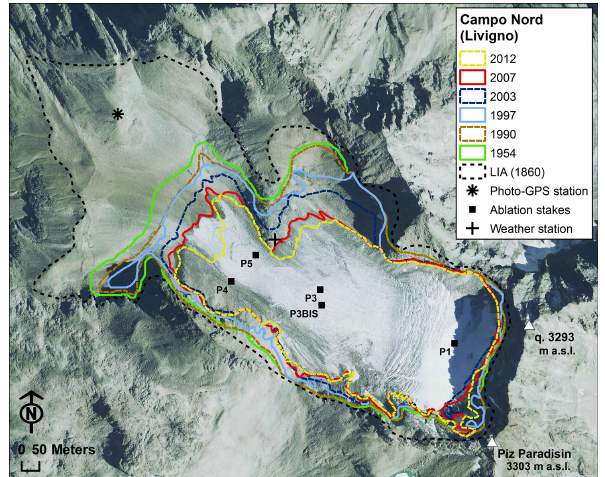
Figure 3. Example of multitemporal glacier delineation, i.e., Campo Nord glacier (Livigno sub-region), with the 2007 or- thophoto in the background. The slightly larger extension of the glacier top area in 2012 compared to 2003 and 2007 is due to the presence of a snow field developed after the 2007 season that was characterized by very limited snow